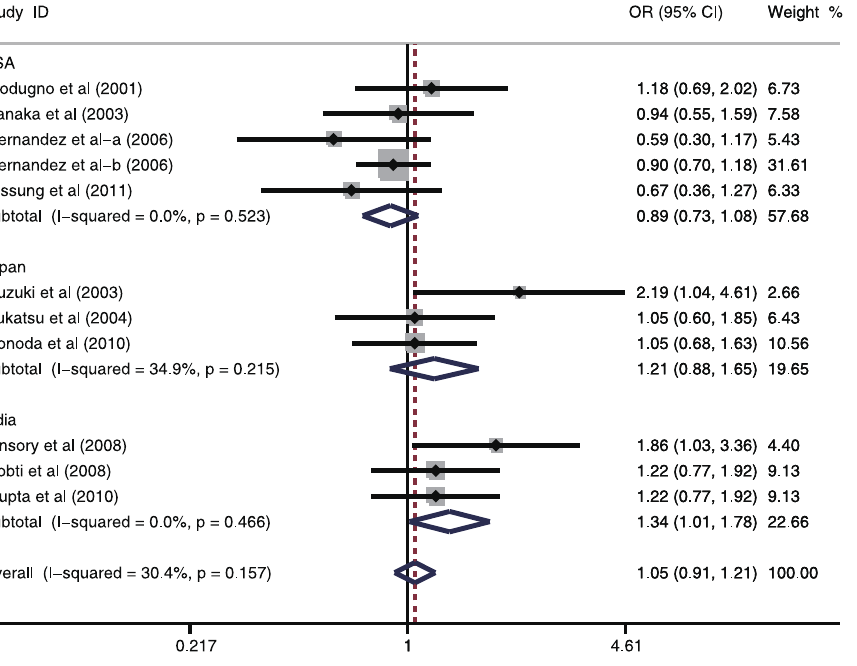
Figure 3. Subgroup analysis by country of ORs with a random-effects model for associations between ESR1 PvuII (C . T) polymorphism and prostate cancer risk under dominant model (TT + TC vs. CC).